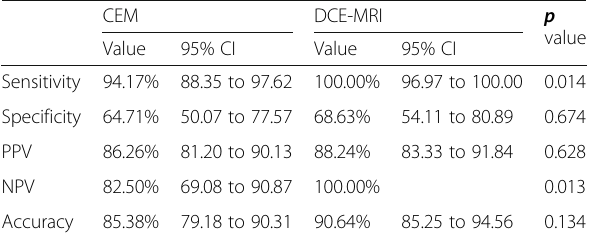
Table 2 Comparison of CEM and DCE-MRI breast diagnostic indices CEM